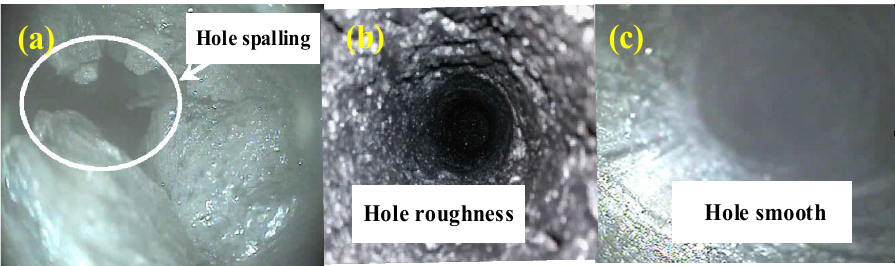
Figure 9. Borehole form: ( a ) hole spalling; ( b ) hole roughness and ( c ) hole smooth. Table 2. Time required and temperature change rate at different stages of coring process.